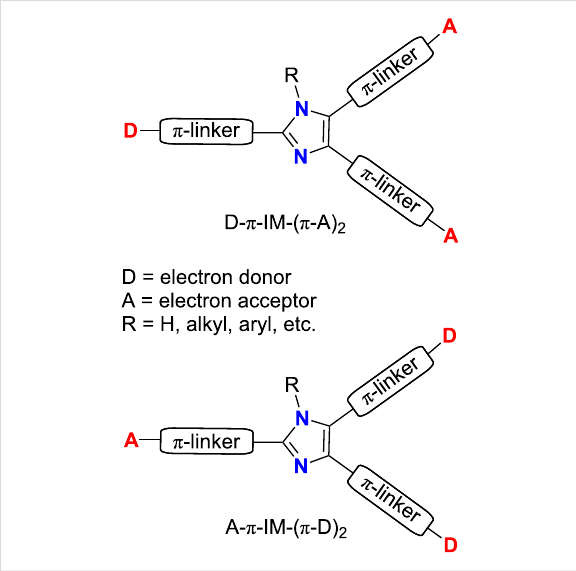
Figure 2: Two principal orientations of the imidazole-derived charge- transfer chromophores.